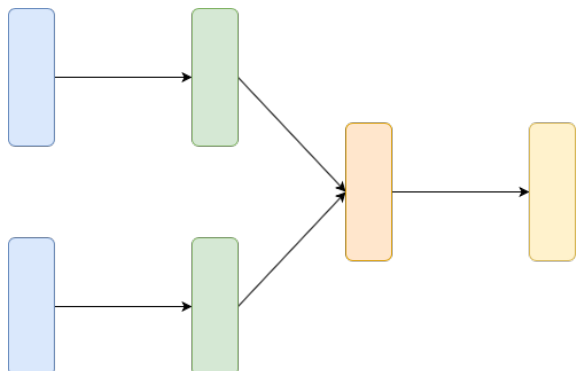
Figure 4. Simple Siamese Neural Network architecture. Layers with the same color share the